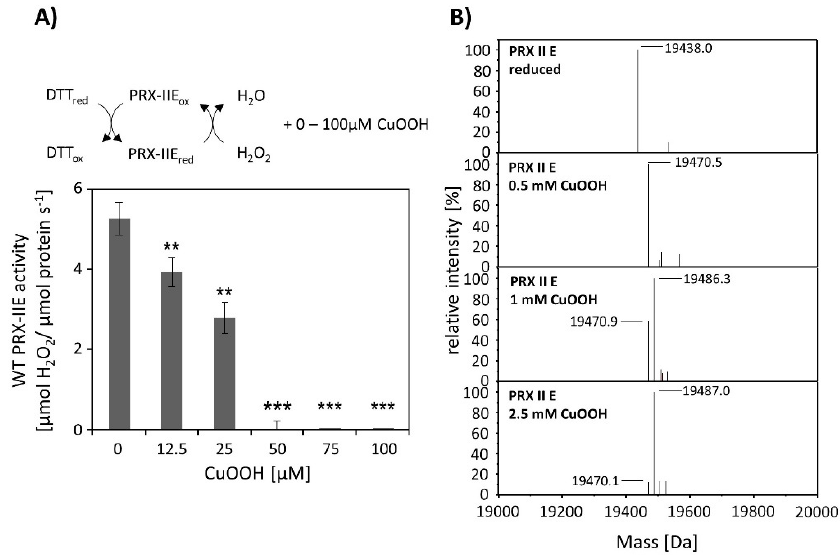
Figure 3. Hyperoxidation of PRX-IIE. ( A ) Activity of 2 µ M PRX-IIE was determined with 400 µ M H 2 O 2 as substrate and 4 mM DTT using the FOX assay. CuOOH concentrations > 50 µ M completely inhibited the peroxidase activity. Data are means of n = 9 ± SD with protein of three independent protein purifications. **: p < 0.01; ***: p < 0.001. ( B ) Deconvoluted ESI-MS spectra of wild-type PRX-IIE after treatment with CuOOH as described in Materials and Methods. 19,438.0 is the expected mass of the reduced (-SH), His-tagged PRX-IIE protein. The peak at 19,470.5 Da after incubation with 0.5 mM CuOOH shows a mass increase by 32 Da, which corresponds to the formation of the sulfinic acid derivative (-SO 2 H). Higher CuOOH concentrations lead to further oxidation to the sulfonic acid (-SO 3 H). Data are representative spectra of n = 15 measurements with the protein of three independent protein purifications. Table 1. CuOOH-dependent thiol modifications of PRX-IIE variants. Proteins were treated with DTT or CuOOH for 1 h at RT and then analyzed by ESI-MS. Generation of the oxidized (-SOH) and hyperoxidized (-SO 2 H, -SO 3 H) forms increased the mass of the protein by 16, 32, or 48 Da. Data are means ± SD, n = 10 with protein from two independent purifications.